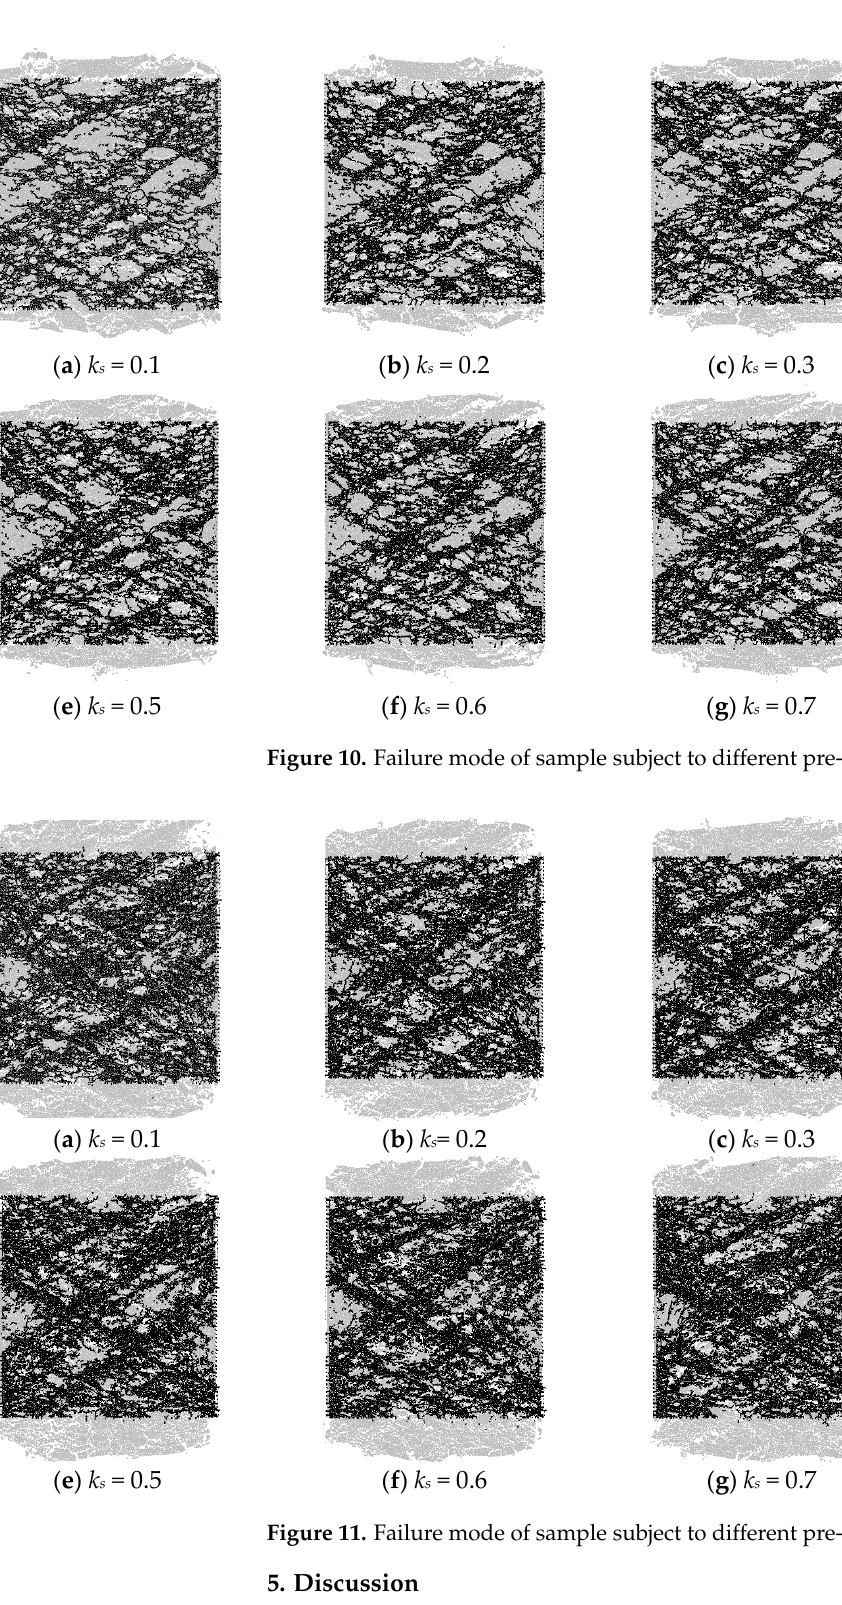
Figure 9. Failure mode of sample subject to different pre-stress levels at 4 m/s impact speed.